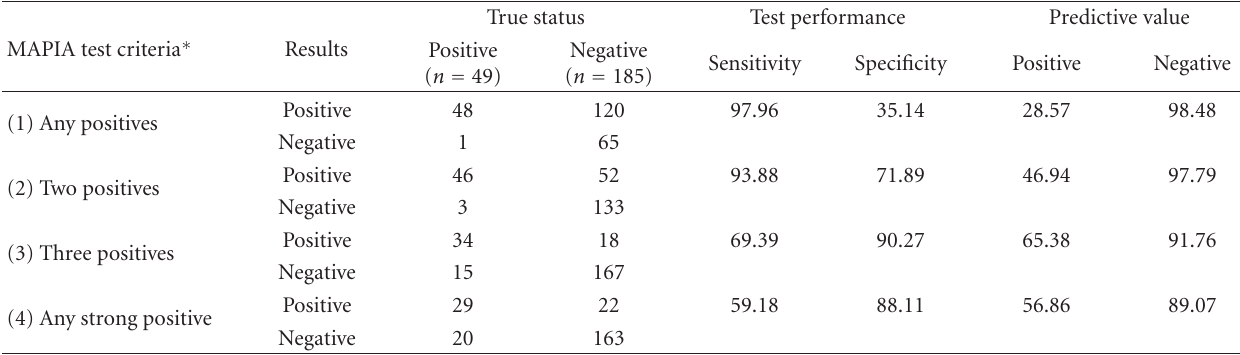
Table 1: Sensitivity, specificity, positive predictive value, and negative predictive value of the MAPIA test, using four di ff erent interpretation criteria.